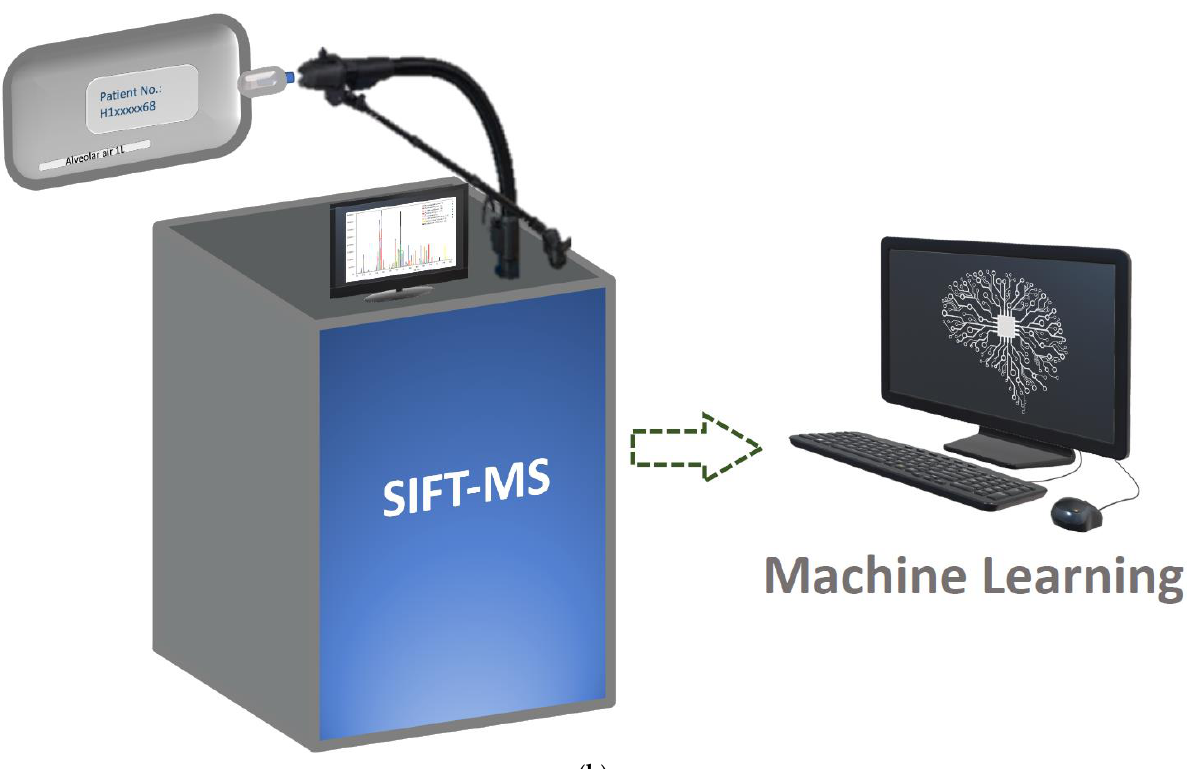
Figure 1. The research flow chart. ( a ) Collecting the alveolar air. The breath was exhaled through the mouthpiece with a direct-connect three-way valve. At the first stage, the exhaled air flows through Exit 1. When the volume of the front portion of the exhaled air reaches 0.2 L, the three-way valve switches to Exit 2 and starts to collect the rest of the exhaled air, i.e., alveolar air, in a 1.0 L aluminum bag. The process of sample collection may be repeated 2–3 times to collect enough samples for analysis. ( b ) Delivery and analysis of an exhaled sample. Selected ion flow tube mass spectrometry (SIFT-MS) extracts the exhaled breath from an aluminum bag and analyzes the composition of volatile organic compounds (VOCs). The VOC data are used for model construction, machine learning, and prediction of lung